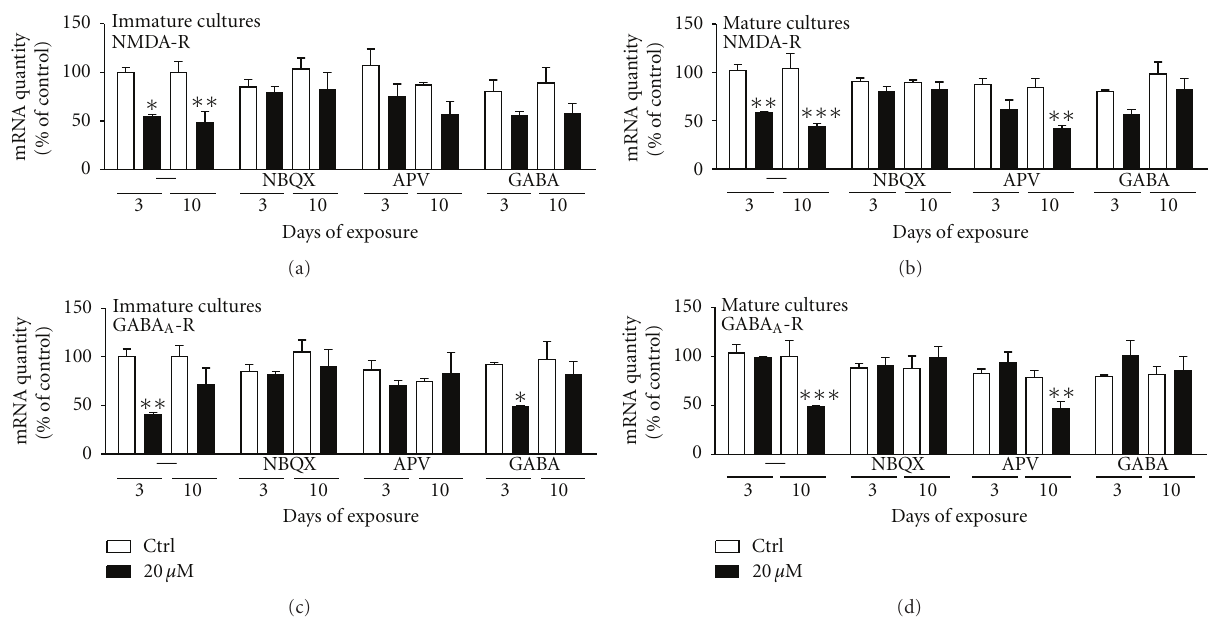
Figure 5: Changes in the mRNA levels of neural receptors in primary cultures of CGCs exposed to 20 μ M domoic acid alone or in combination with antagonists for the AMPA-R (NBQX, 20 μ M), NMDA-R (APV, 100 μ M), or the neurotransmitter GABA (10 μ M) at 1 DIV (immature cultures) or at 7 DIV (mature cultures) for 3 or 10 days. Note that NBQX completely and APV and GABA partly prevent the domoic acid induced downregulation of (a) NMDA-R in immature cultures, (b) NMDA-R in mature cultures, (c) GABA A -R mRNA expression in immature cultures, and of (d) GABA A -R in mature cultures. Gene expression levels were normalized to the standard calibrator, the housekeeping gene 18S rRNA and the mRNA expression at 1 DIV. Data represent mean ± S.E.M. of three independent experiments performed in duplicates. ∗ P < 0 . 05 ∗∗ P < 0 . 01 ∗∗∗ P < 0 . 001 comparing treated to control (untreated)